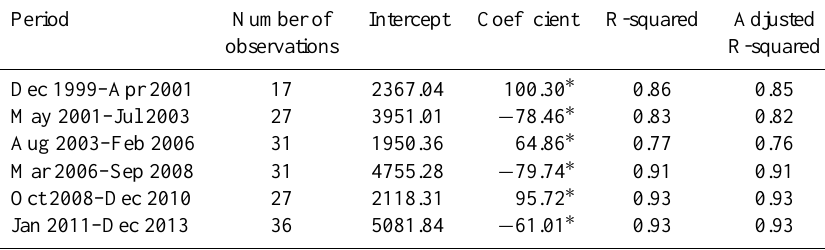
Table 1. Results of linear regression analysis of six segments of sugar price over a long period. Period Number of